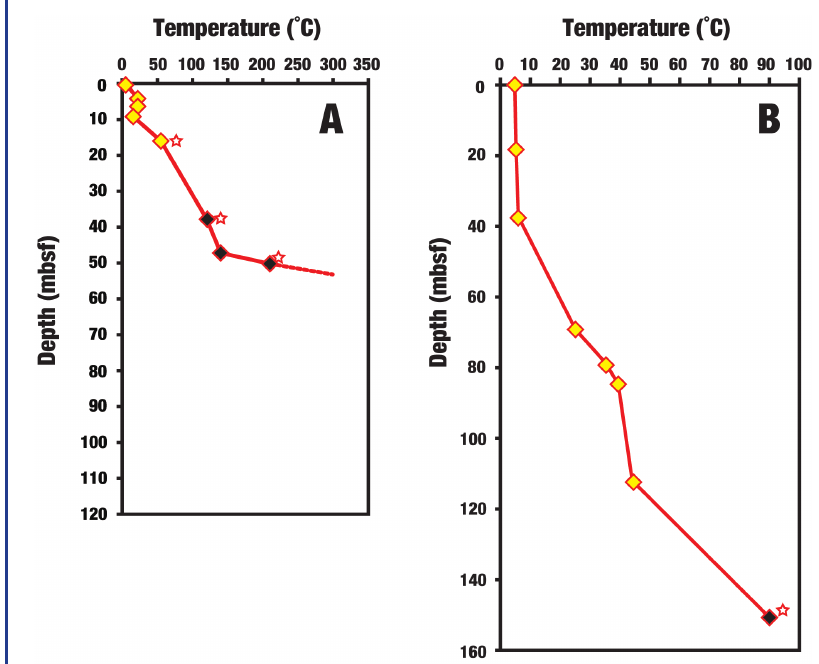
Figure 7. Depth profile of temperature in the subseafloor at Sites [A] C0014 and [B] C0017 as measured by the APCT3 shoe and thermoseal chemically impregnated temperature-sensitive strips. Yellow=APCT3, black=thermoseal strip. Stars=minimum values. Modified from Takai et al.